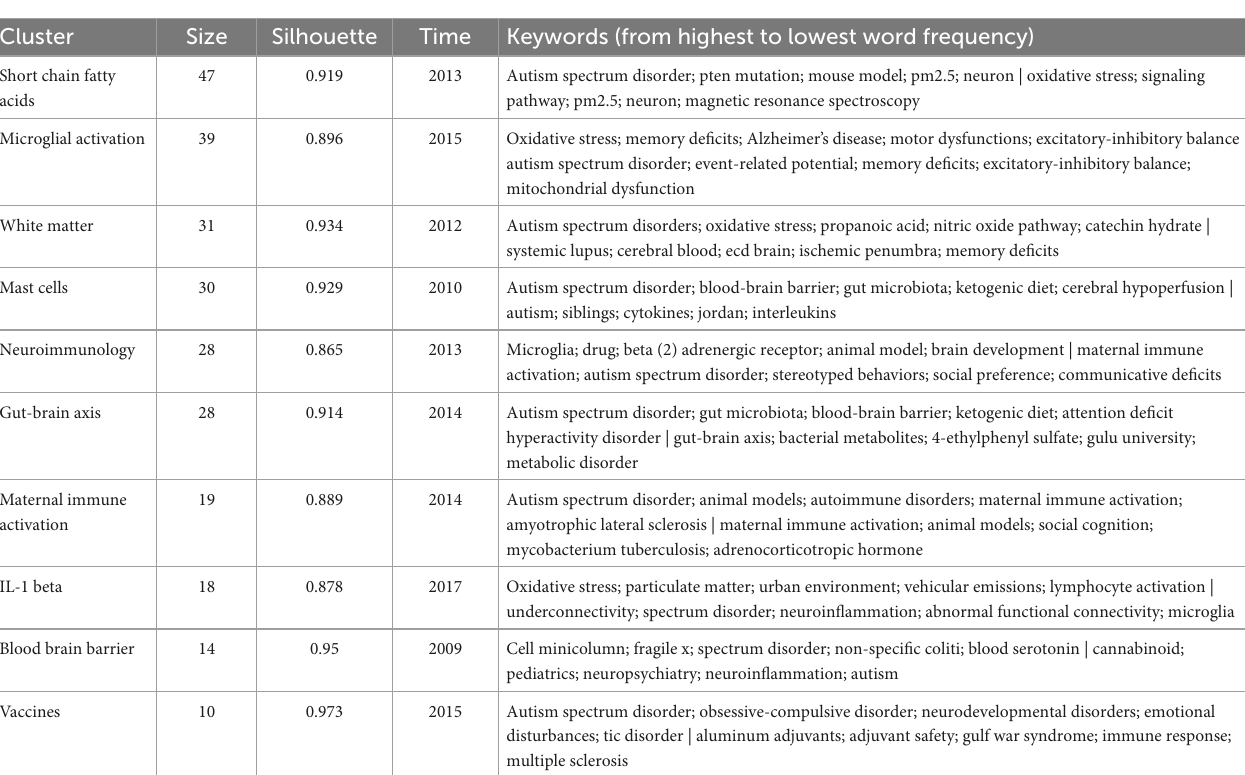
TABLE 3 Details of keyword clusters. Size Silhouette Time Keywords (from highest to lowest word